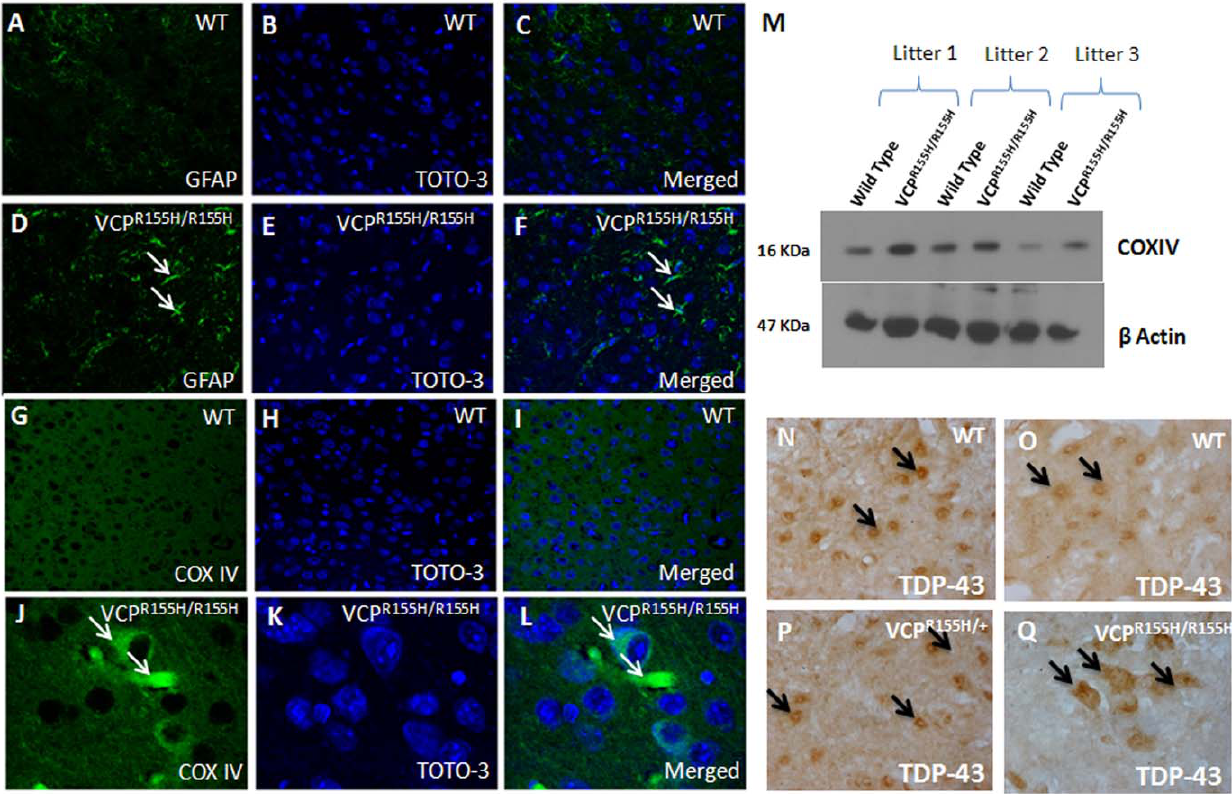
Figure 5. Immunohistochemical analyses of GFAP and COX-IV expression in VCP R155H/R155H and WT brains and spinal cords. GFAP expression levels in (A–C) WT and (D–F) VCP R155H/R155H animals. COX-IV enzyme expression levels in (G–I) WT and (J–L) VCP R155H/R155H animals. (M) Western blot analysis of COX-IV enzyme expression level in VCP R155H/R155H and WT brains. b actin was used as a loading control. (N–Q) TDP-43 immunoreactivity of the WT, VCP R155H/ + , and VCP R155H/R155H spinal cords. Note the nuclear and occasional faint cytosolic staining of TDP-43 in the (N,O) WT littermates in contrast to the strong cytosolic aggregation of TDP-43 seen in the (P) VCP R155H/ + heterozygote and (R) VCP R155H/R155H homozygote mice (as indicated by black arrows) (Bar=50 m m, Mag 40 6 ).